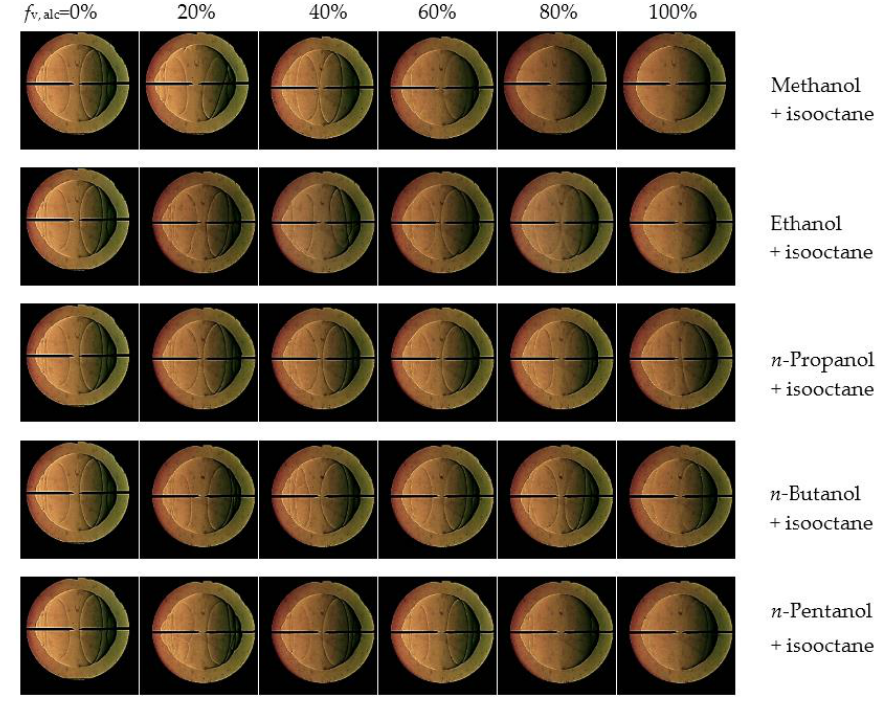
Figure 12. Schlieren images of C1–C5 primary alcohol-isooctane blends at 363 K, 0.1 MPa and equivalence ratio of 1.5.